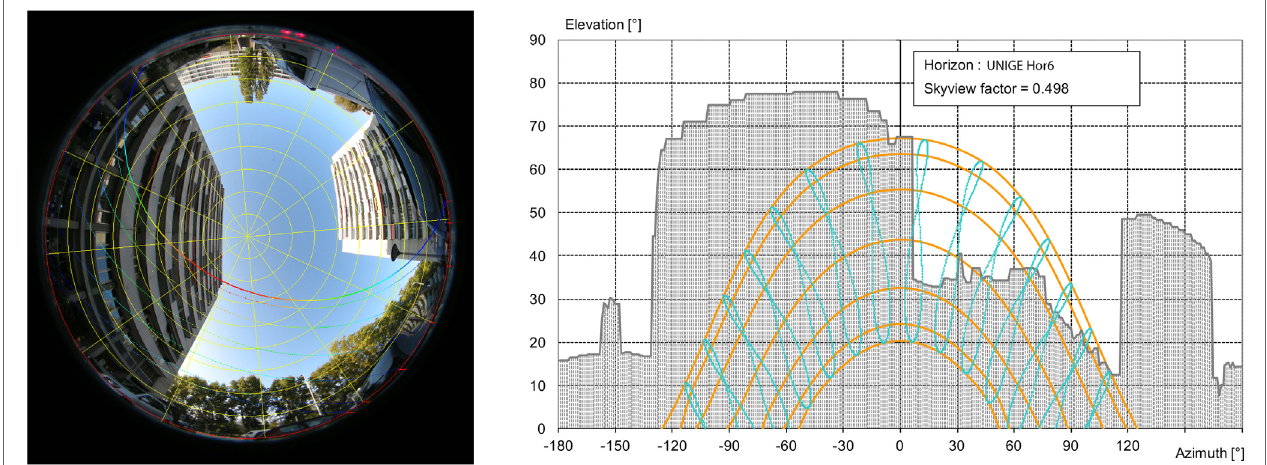
FIGURe 12 | Illustration of the construction of the horizon from fisheye catchment in point 6: image of the circular stereographic projection (left) and projection into Cartesian coordinate system (right). Reproduced from Ineichen (2012). No permission is required from the copyright holder for the use of this image in this